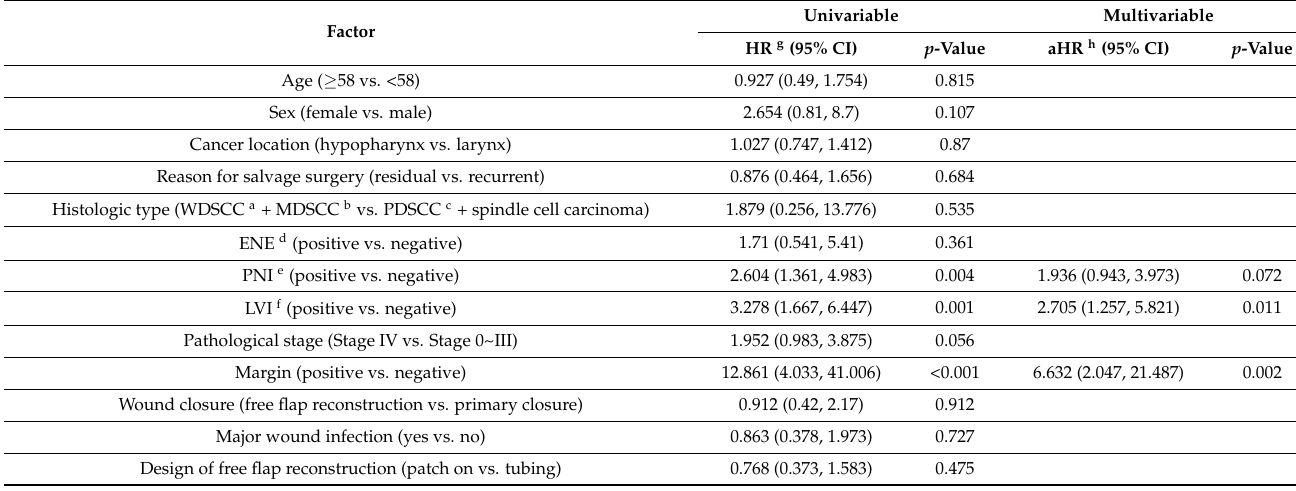
Table 4. Univariable and multivariable Cox analysis of prognostic factors associated with disease-free survival.